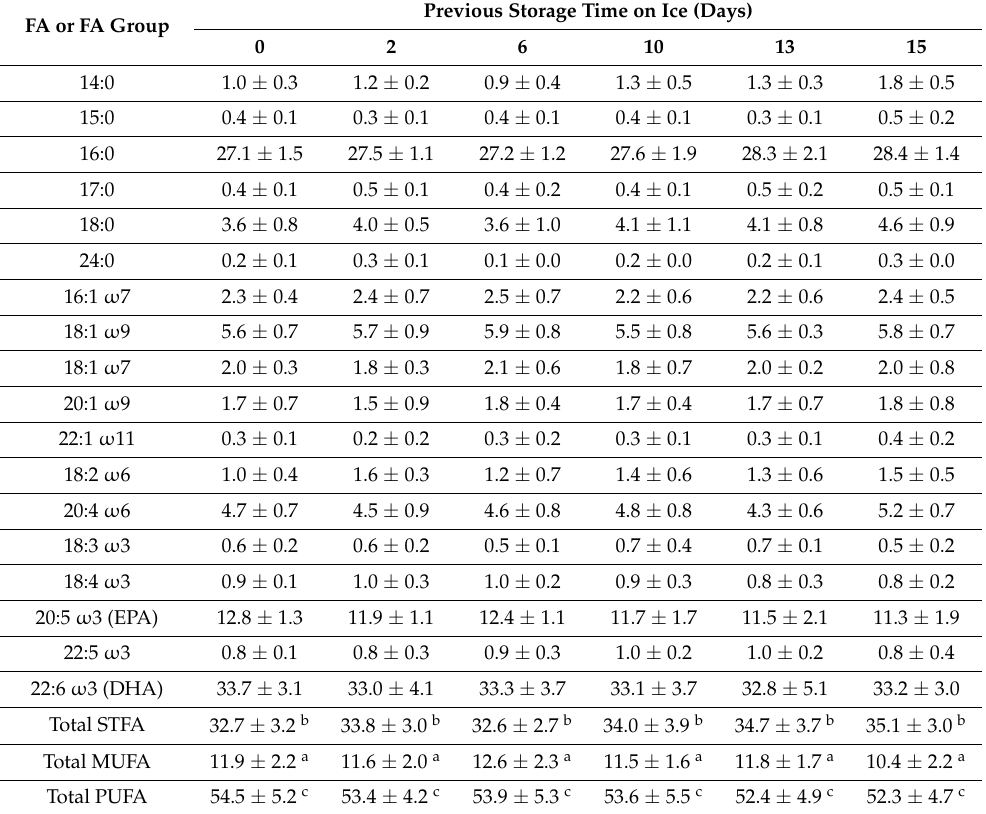
Table 2. Fatty acid (FA) analysis (g · 100 g − 1 total FA) of canned sardines subjected to storage on ice before